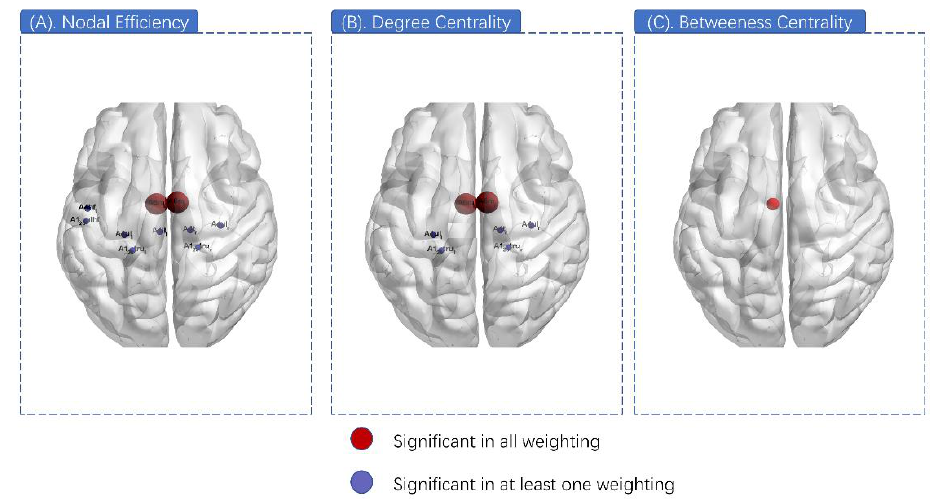
Figure 6. Nodal properties differences. ( A ) Ten nodes exhibited a significant difference in at least